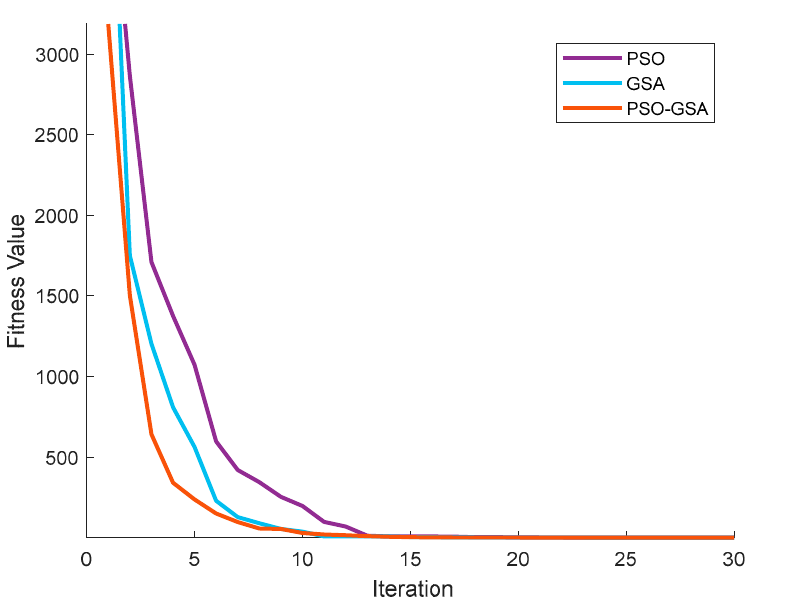
Figure 17. Best value obtained from 30 different implementations for the standard test function.